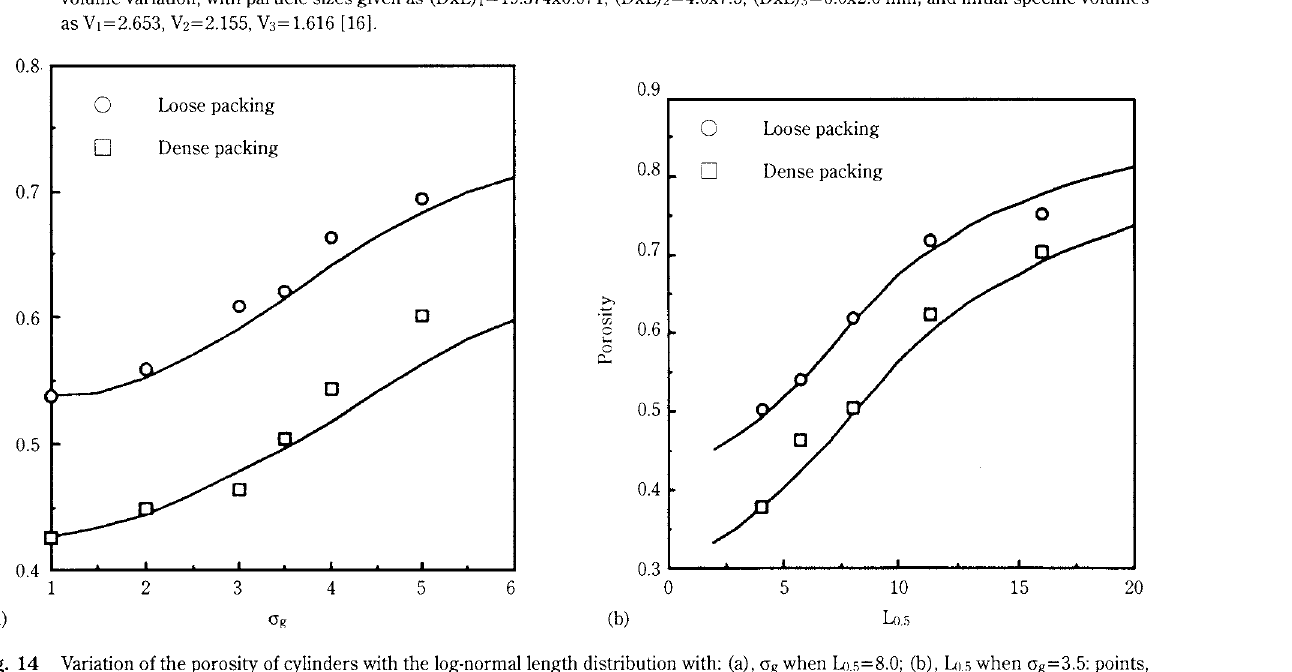
Fig. 14 Variation of the porosity of cylinders with the log-normal length distribution with: (a), <Jg when L1s=8.0; (b), LL5 when <Jg=3.5: points, measurements [44];